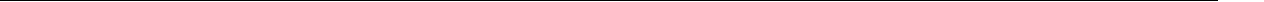
Fig. 7 No reconstitution of the PC pool in Postn KO periosteum after fracture. a Experimental design for the isolation of periosteum graft from GFP donor mice and transplantation at the fracture site of wild-type hosts. b SO staining and DAPI/GFP immuno fl uorescence on longitudinal sections of mouse fractured tibias post transplantation with GFP periosteum graft. At d28 post fracture (d28-new periosteum), high magni fi cation shows rare periosteum- derived GFP + cells that integrate in the new bone to form osteocytes (white arrow) and in the new periosteum (white arrowheads). After a second fracture performed at the level of the fi rst callus, abundant periosteum-derived GFP + cells are found in the callus and form cartilage (white arrowheads) and bone (white arrows) (d7-callus) and few GFP + cells reintegrate the new periosteum at d28 (white arrowheads) (d28-new periosteum). After a third fracture, periosteum-derived GFP + cells can again form cartilage ef fi ciently in the callus by day 7 (white arrowhead) (day 7-callus). c Cell sorting and FACS analyses on PCs and BMSCs isolated from ossi fi ed calluses (d14). PCs and BMSCs derived from the periosteum graft were detected based on the expression of the GFP (0.06% and 0.01%, respectively). Cell sorting was performed to enrich the population in GFP + cells (orange box) and FACS analyses to assess the expression of hematopoietic-endothelial markers (CD11b, CD31, CD45, and CD34) and Sca1/CD29). In BMSCs cultures, GFP + cells were all positive for hematopoietic-endothelial markers (100%). For PC cultures, we detected a population that was negative for hematopoietic-endothelial markers (35.8%) and positive for Sca1/CD29 (35.9%) ( n = 2 or 3). d Transplantation of Periostin KO grafts into wild-type hosts. No GFP + cells are detected in the new periosteum (d28 – new periosteum), and no GFP + chondrocytes contribute to the callus after a second injury. These Periostin KO grafts induced fi brosis at the fracture site of wild-type hosts (d7 – callus). SO: Safranin-O/Fast Green, PS: Picro Sirius, cal: callus, po: periosteum, nb: new bone, ca: cartilage, white dashed line: periosteum (d28) or new bone (d7), orange dashed line: callus, yellow line: periosteum transplant, asterisk: cartilage formation opposite to transplant ( n = 4). Scale bar = 1